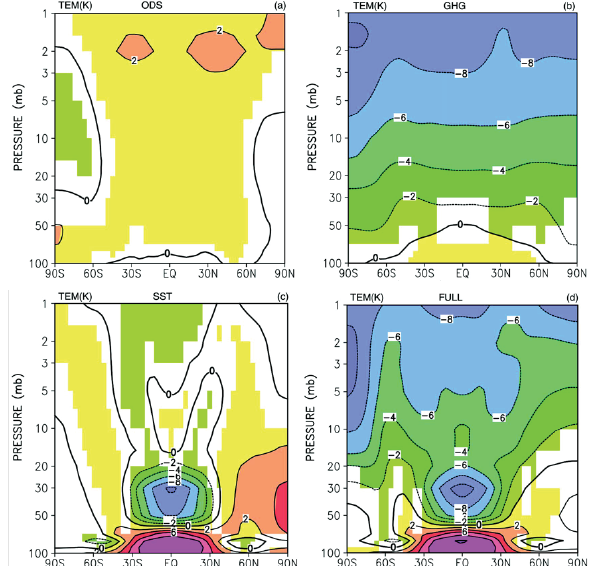
Fig. 1. Zonal, annual and ensemble mean changes of the temper- ature (K) from 2000 to 2100 caused by (a) ODS; (b) GHG; (c) SST/SI; (d) all factors (ODS, GHG, and SST/SI). Color pattern in- dicates the regions where the changes are judged statistically sig- nificant at or better than 5% level. Positive changes are shown in reddish colors while small or negative changes are colored in blue/violet.